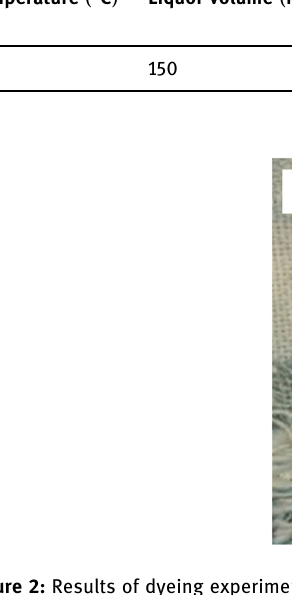
Table 3: Test condition of color fastness to domestic laundering Temperature ( °C )